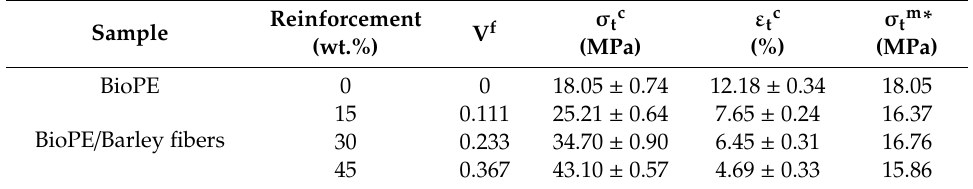
Table 3. Tensile properties of BioPE composites reinforced with barley